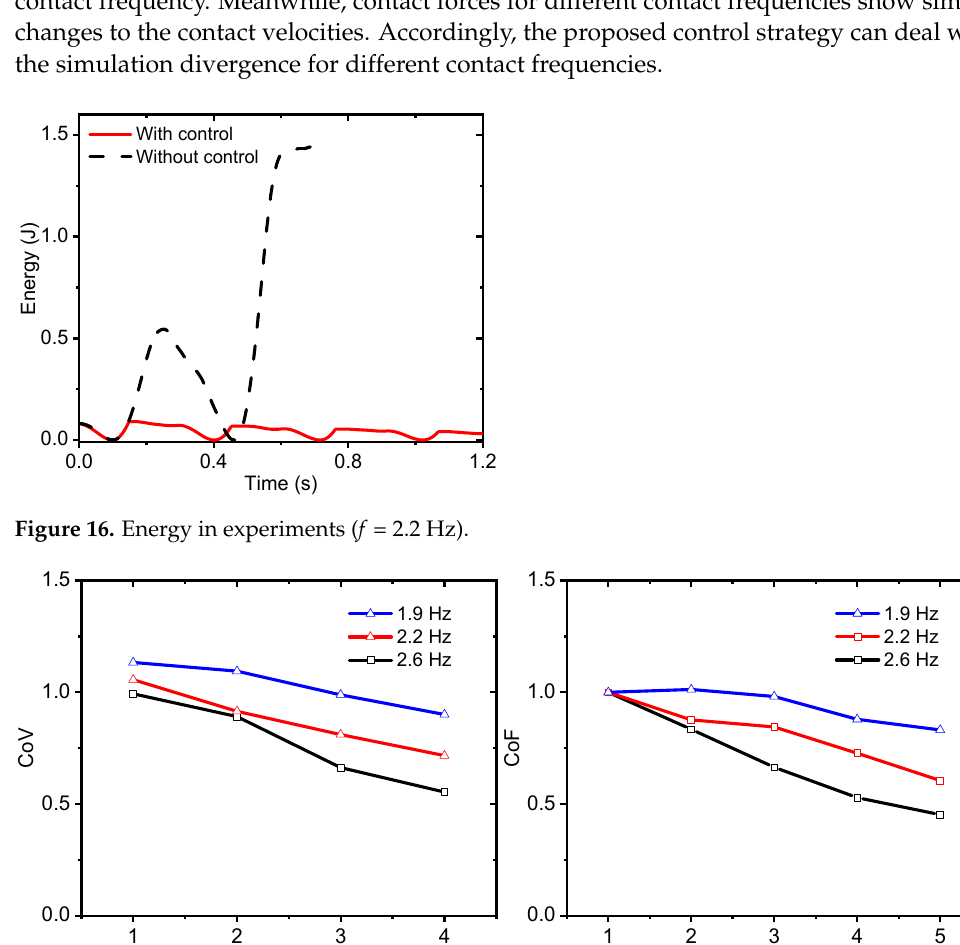
Figure 15. Contact velocities and forces in experiments ( f =2.2 Hz). ( a ) Velocities. ( b ) Forces.